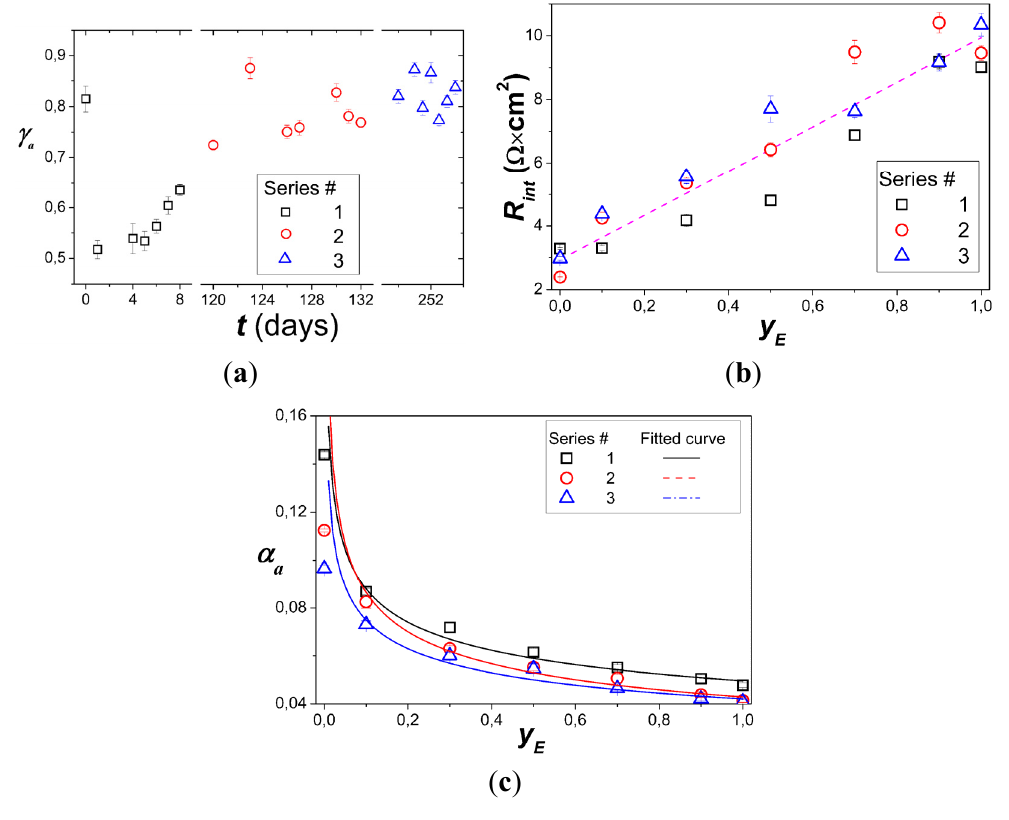
Figure 4. Fitting parameters evolution during long term fuel cell operation (adapted from